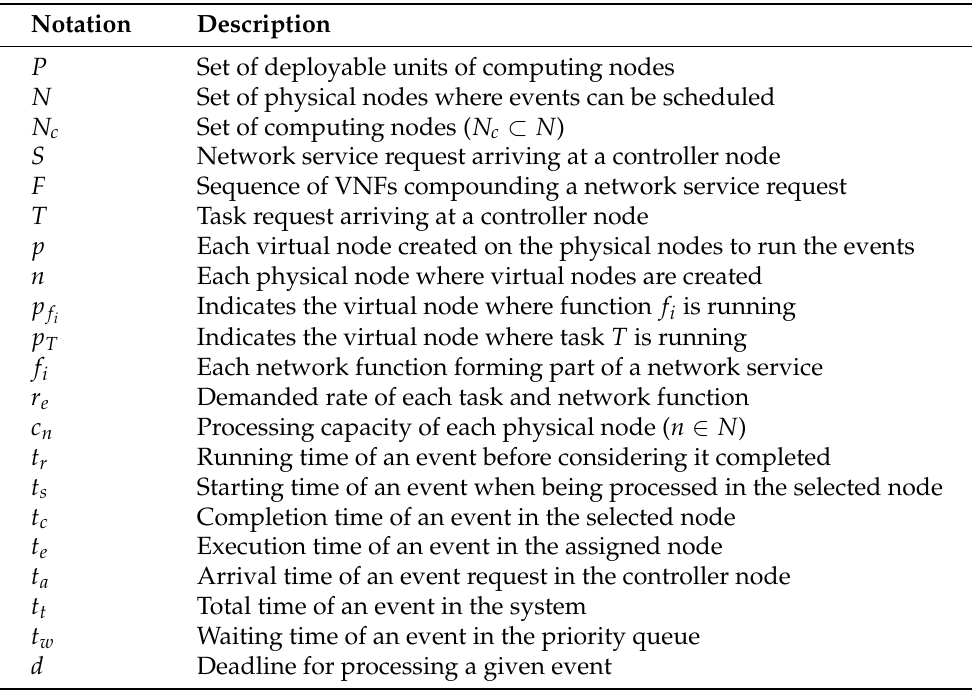
Table 1. System model